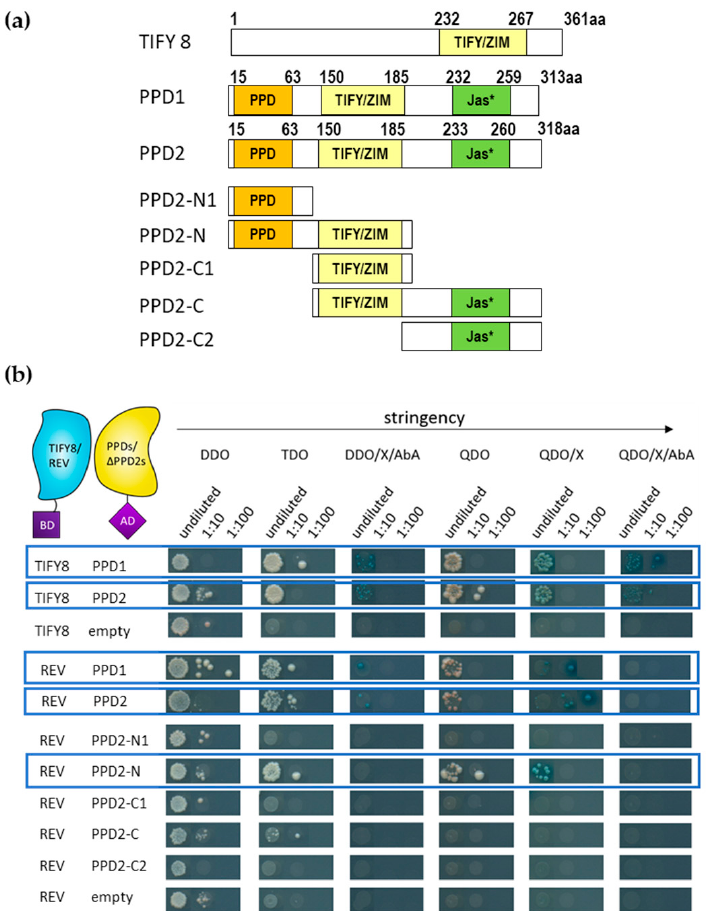
Figure 8. Yeast two-hybrid interactions between PEAPODs, PPD2-truncated proteins, TIFY8, and REV. ( a ) Scheme of the PPD1, PPD2, TIFY8, and truncated PPD2 versions used in the yeast two-hybrid assay. The orange box represents the PEAPOD domain (PPD), the yellow box represents the TIFY/ZIM domain, and the green box represents the Jas-like domain (Jas*). PPD2 full length (1 to 318aa), PPD2- N1 (1 to 117aa), PPD2-N (1 to 204aa), PPD2-C1 (117 to 204aa), PPD2-C (117-316aa), and PPD2-C2 (205 to 316aa). ( b ) Representative yeast two-hybrid assay between GAL4-BD-TIFY8 or GAL4-REV and PPDs, as well as a series of truncated versions of the PPD2 protein shown in ( a ) fused with GAL4-AD. A serial 1:10 dilution of each transformed yeast was spotted onto control (DDO) and different protein- protein interaction selective media with increasing stringency. Blue boxes indicate interactions.